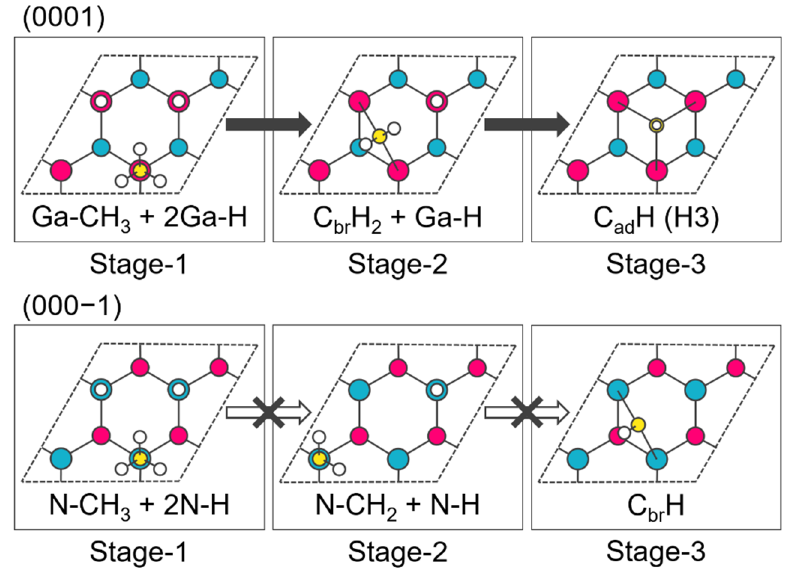
Figure 2. Adsorption structures of CH 4 onto the 3Ga-H and 3N-H (2 × 2) surfaces. Red atoms represent Ga, blue atoms N, yellow atoms C, and white atoms H. Stage-1, Stage-2, and Stage-3 show the structures after the desorption of one, two, and three H 2 molecules, respectively.